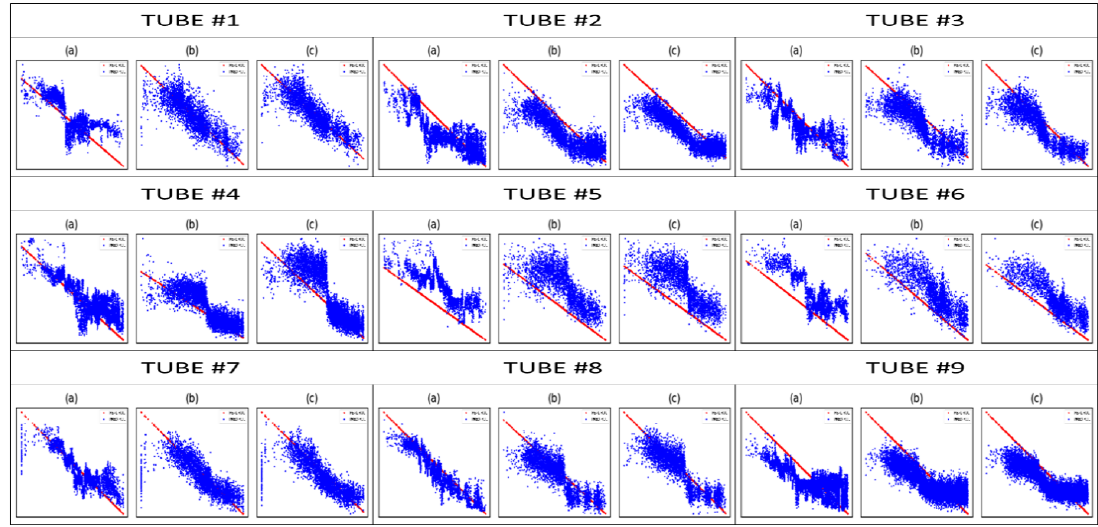
Figure 13. Stress versus RUS plots for each given tube. ( a ) Random-forest (RF), ( b ) Basic CNN and ( c ) SqueezeNet CNN. Blue represents the predicted values while red represents the true values.